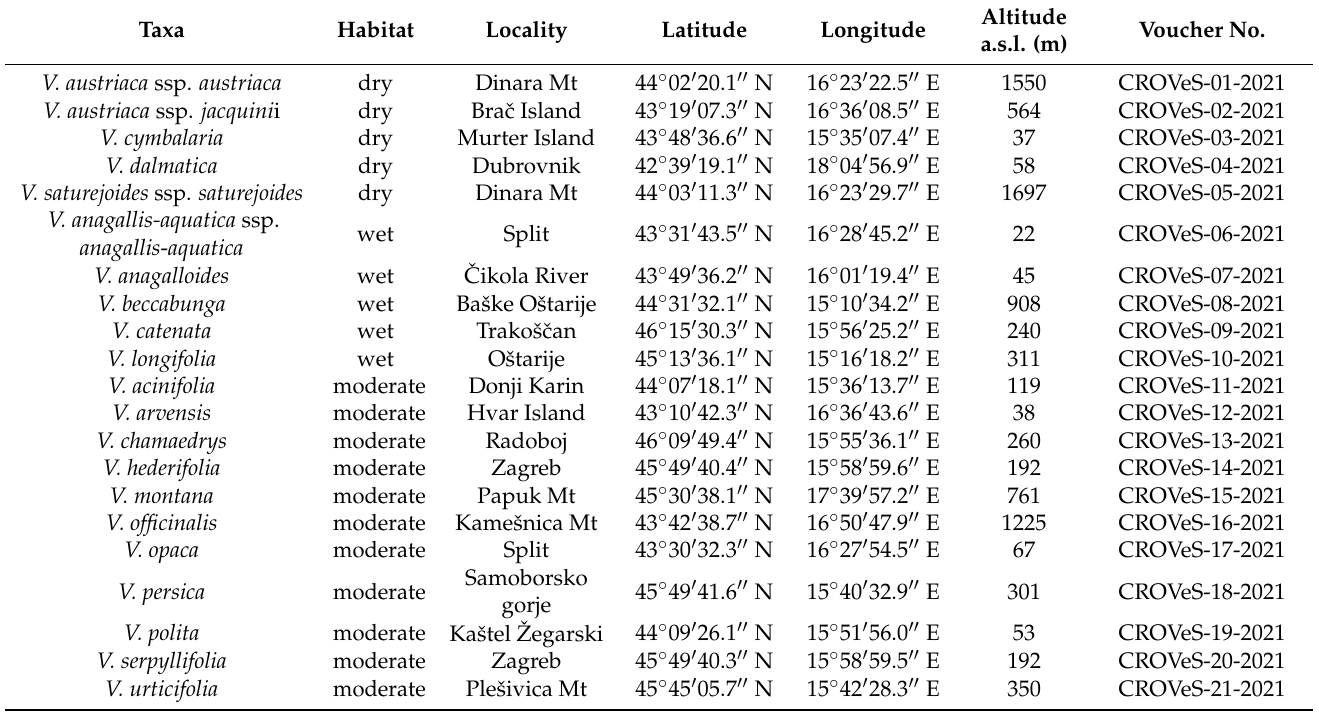
Table 1. Details of the data collection and origin of the investigated Veronica